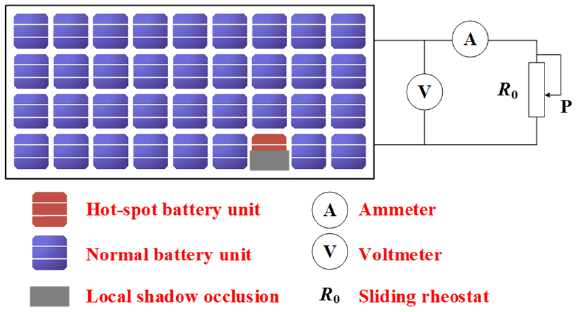
Figure 11. Circuit for measuring I-U characteristics of hot-spot module.